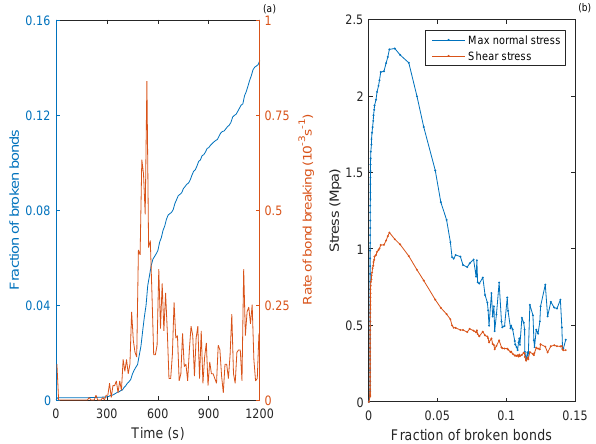
Figure 9. As in Fig. 8 but in simulation under shear